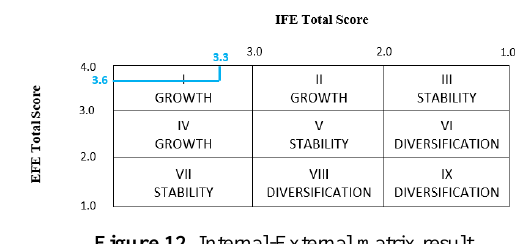
Figure 12 . Internal-External matrix result